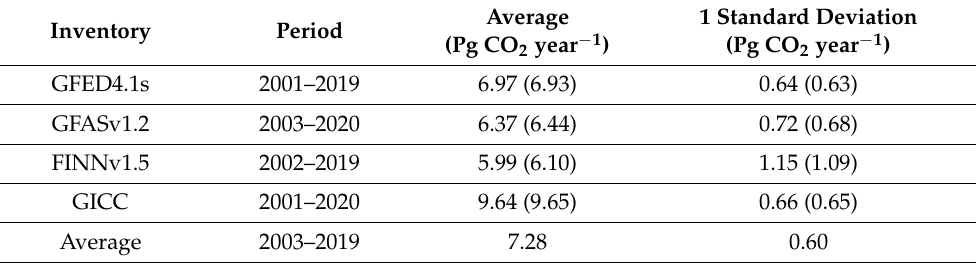
Table 3. Average annual CO 2 emissions for the previous studies. Numbers in parentheses are from 2003 to